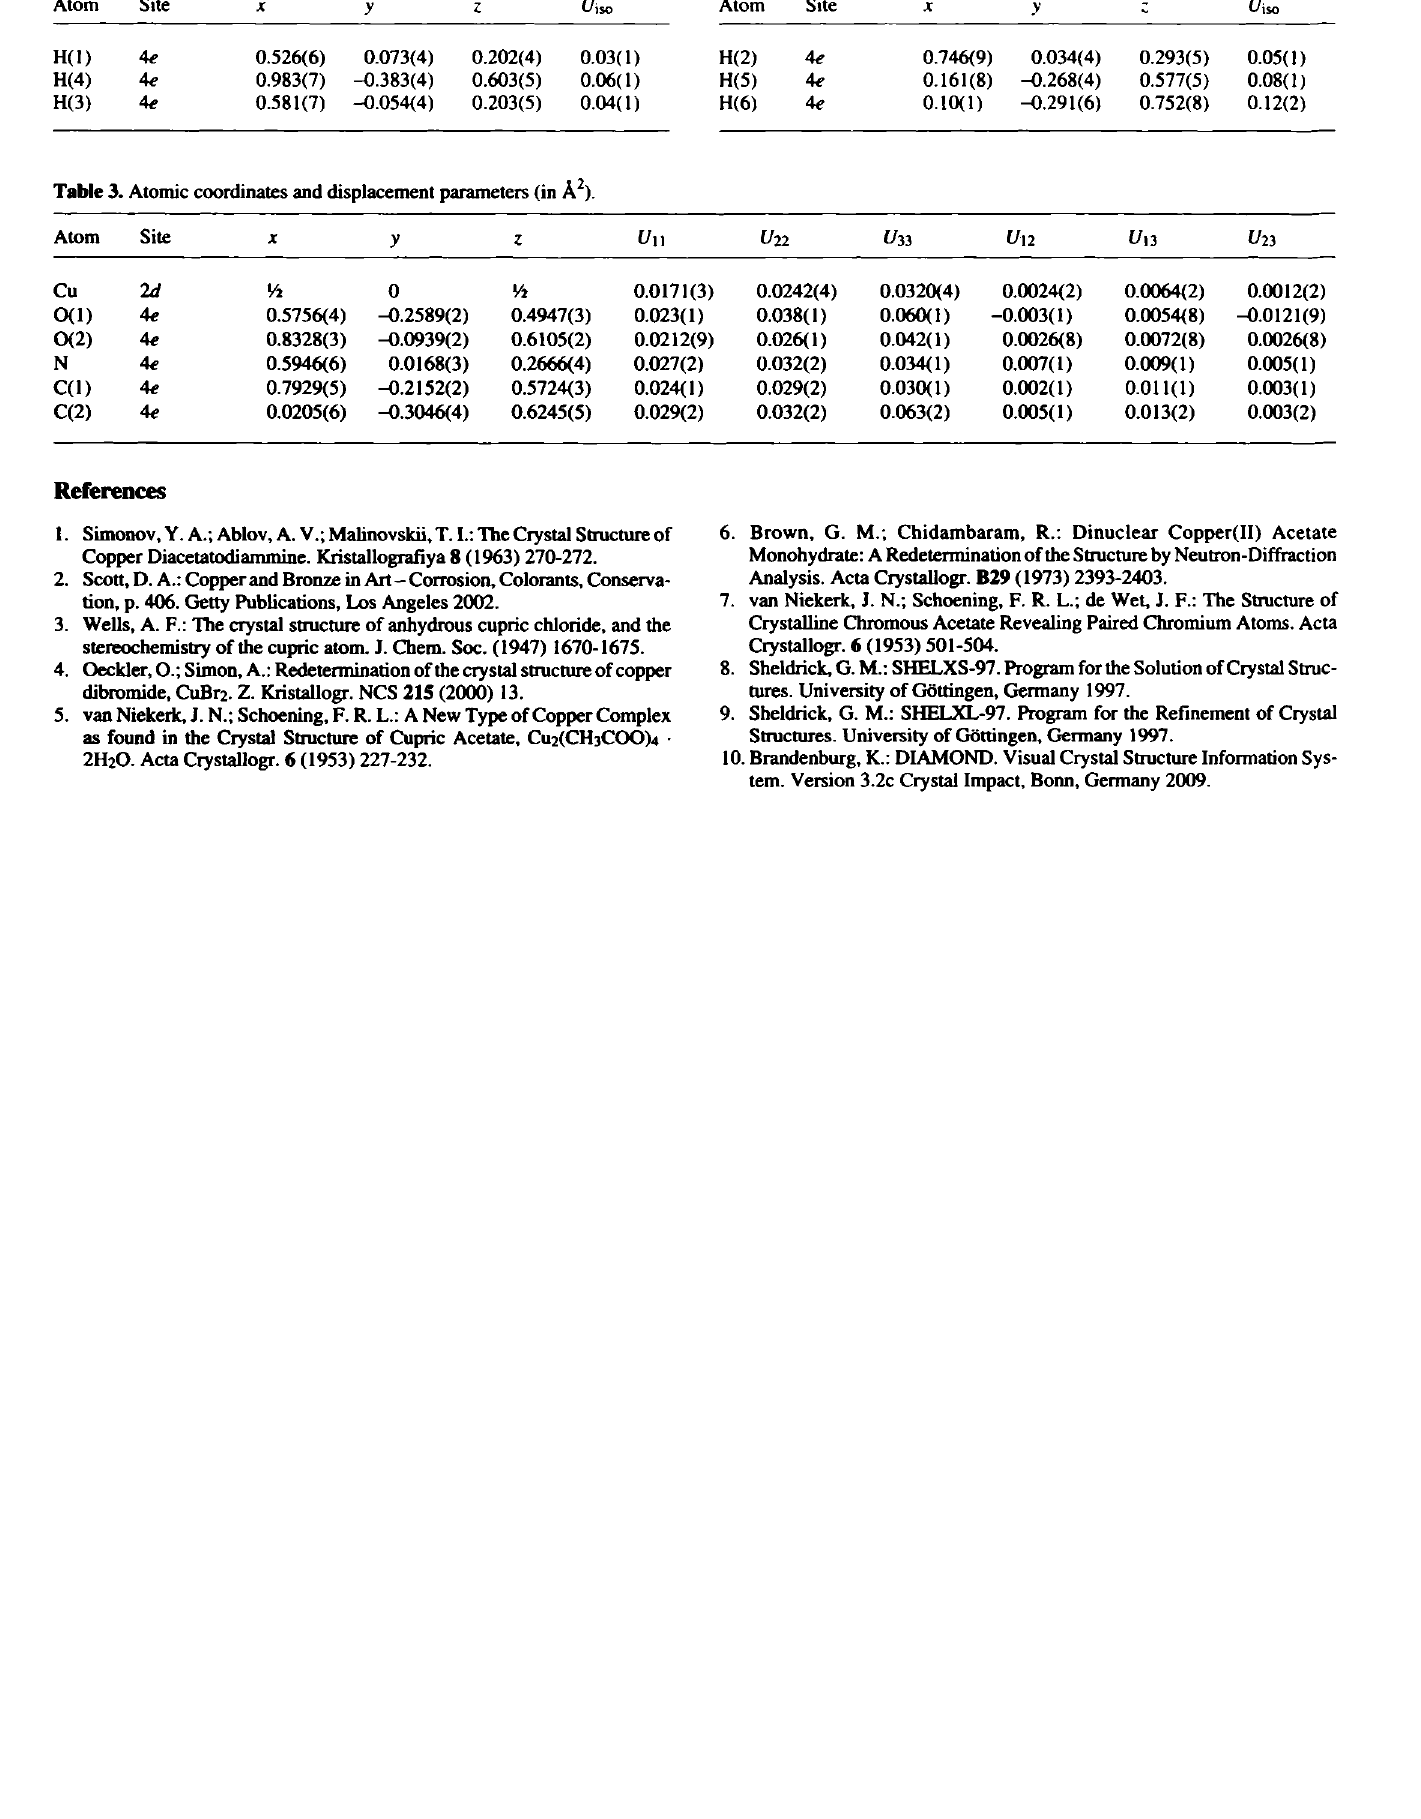
Table 2. Atomic coordinates and displacement parameters (in Â 2 ).